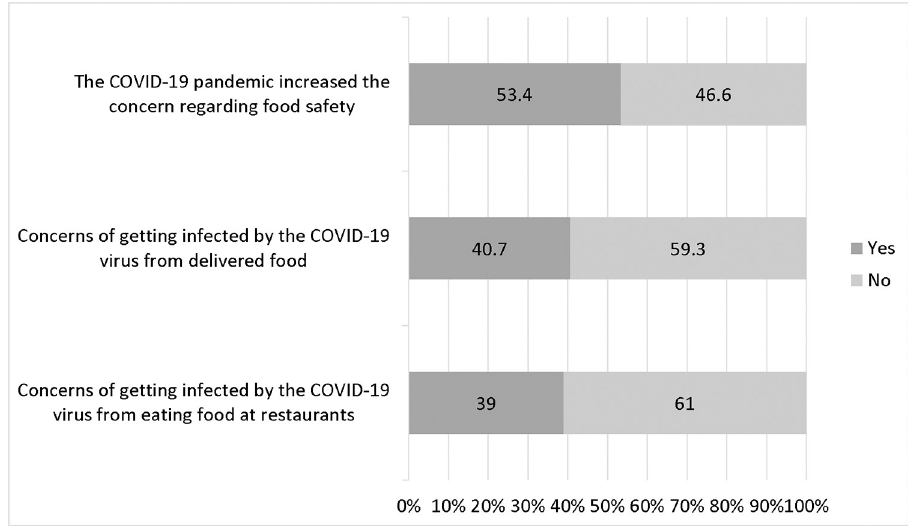
Fig 2. Attitude toward food safety and COVID-19 (n = 325).